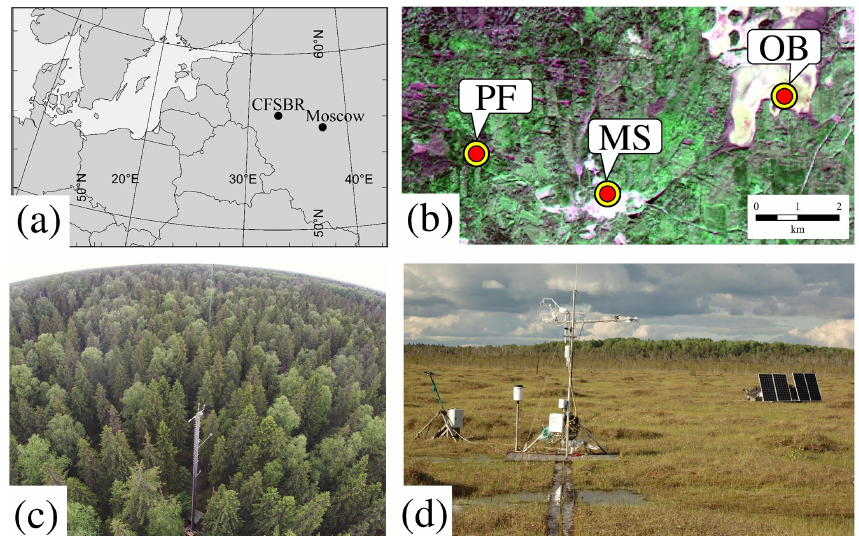
Figure 1. (a) Geographical location of the Central Forest State Nature Biosphere Reserve (CFSNBR). (b) Location of the paludified spruce forest (PF), ombrotrophic bog Staroselsky Mokh (OB), and meteorological station Lesnoy Zapovednik (MS) on a Landsat 8 image. Photos of the eddy covariance stations at the (c) PF and (d) OB